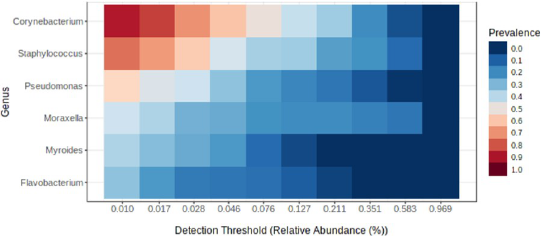
Fig 2. Core bacteriome of nasal samples of health care professionals stationed in a clinical research laboratory. A set of taxa detected in 30% of the population with a prevalence above 0.01 were plotted on the heat map. The relative abundance derived from the count data is plotted on the X-axis. The Y-axis represents the six classified genera.